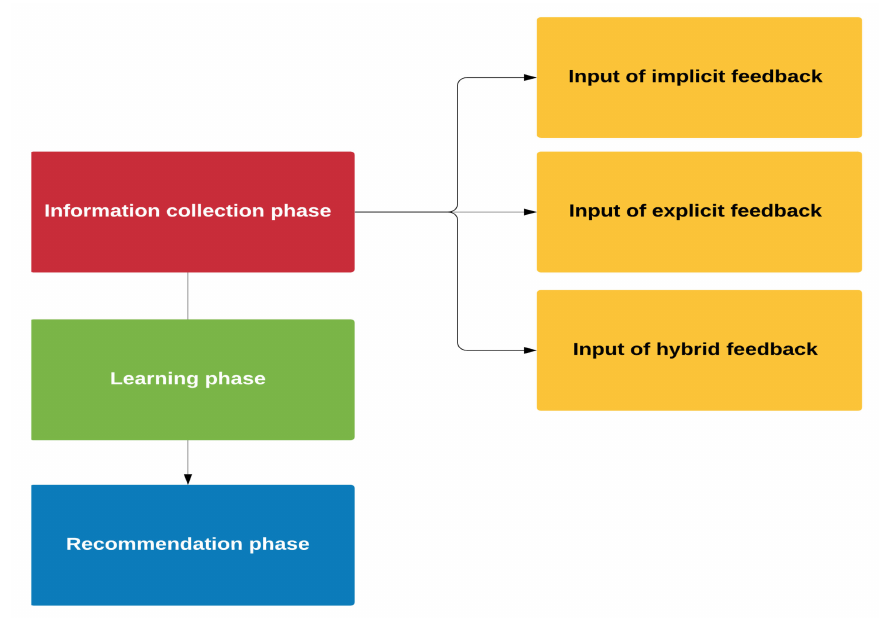
Figure 2. Phases of recommendation